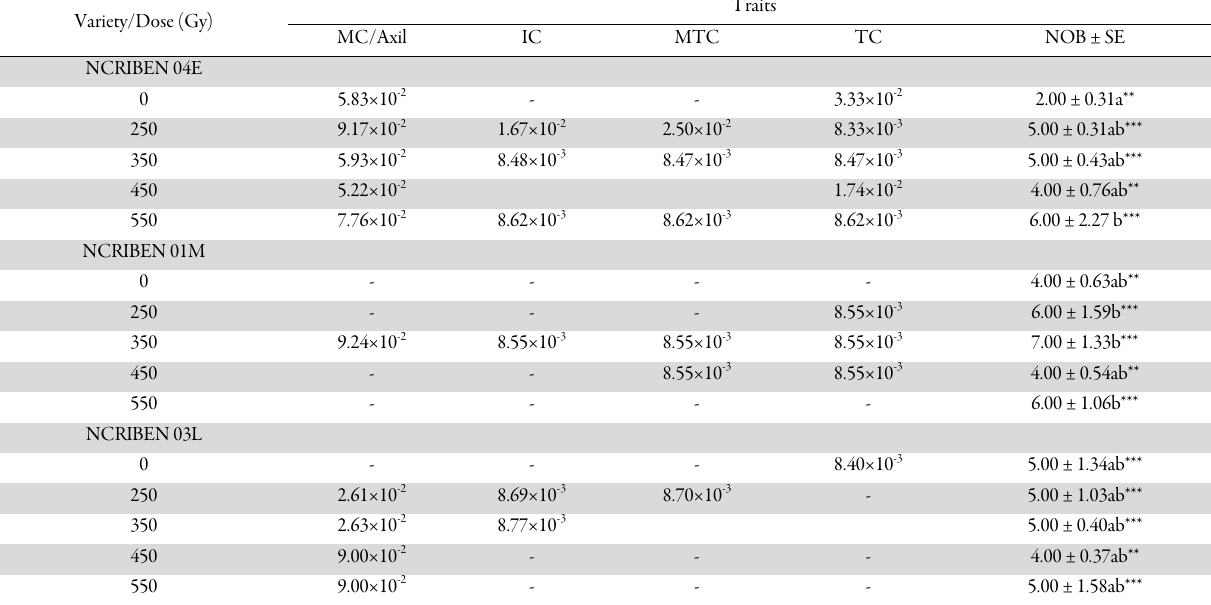
Table 2. Spectrum and frequency of viable mutants in M 1 populations